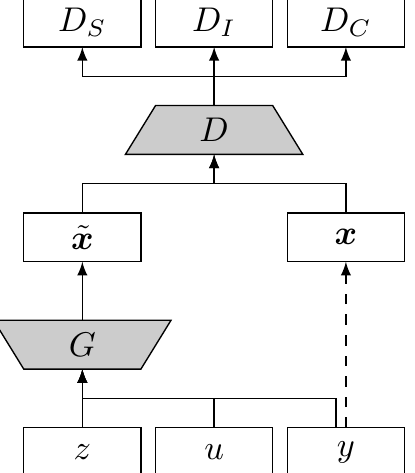
Figure 1. WacGAN-info model configuration. D is the discriminator network, and G is the generator network. z , y , and u are the generator inputs corresponding to noise vector, class vector, and latent info vector, respectively. The signals x and ˜ x are real and artificial data samples. Finally, D S , D C , and D I are the parallel discriminator outputs corresponding to the source distribution estimation (real or artificial samples), the class estimation, and the info variable